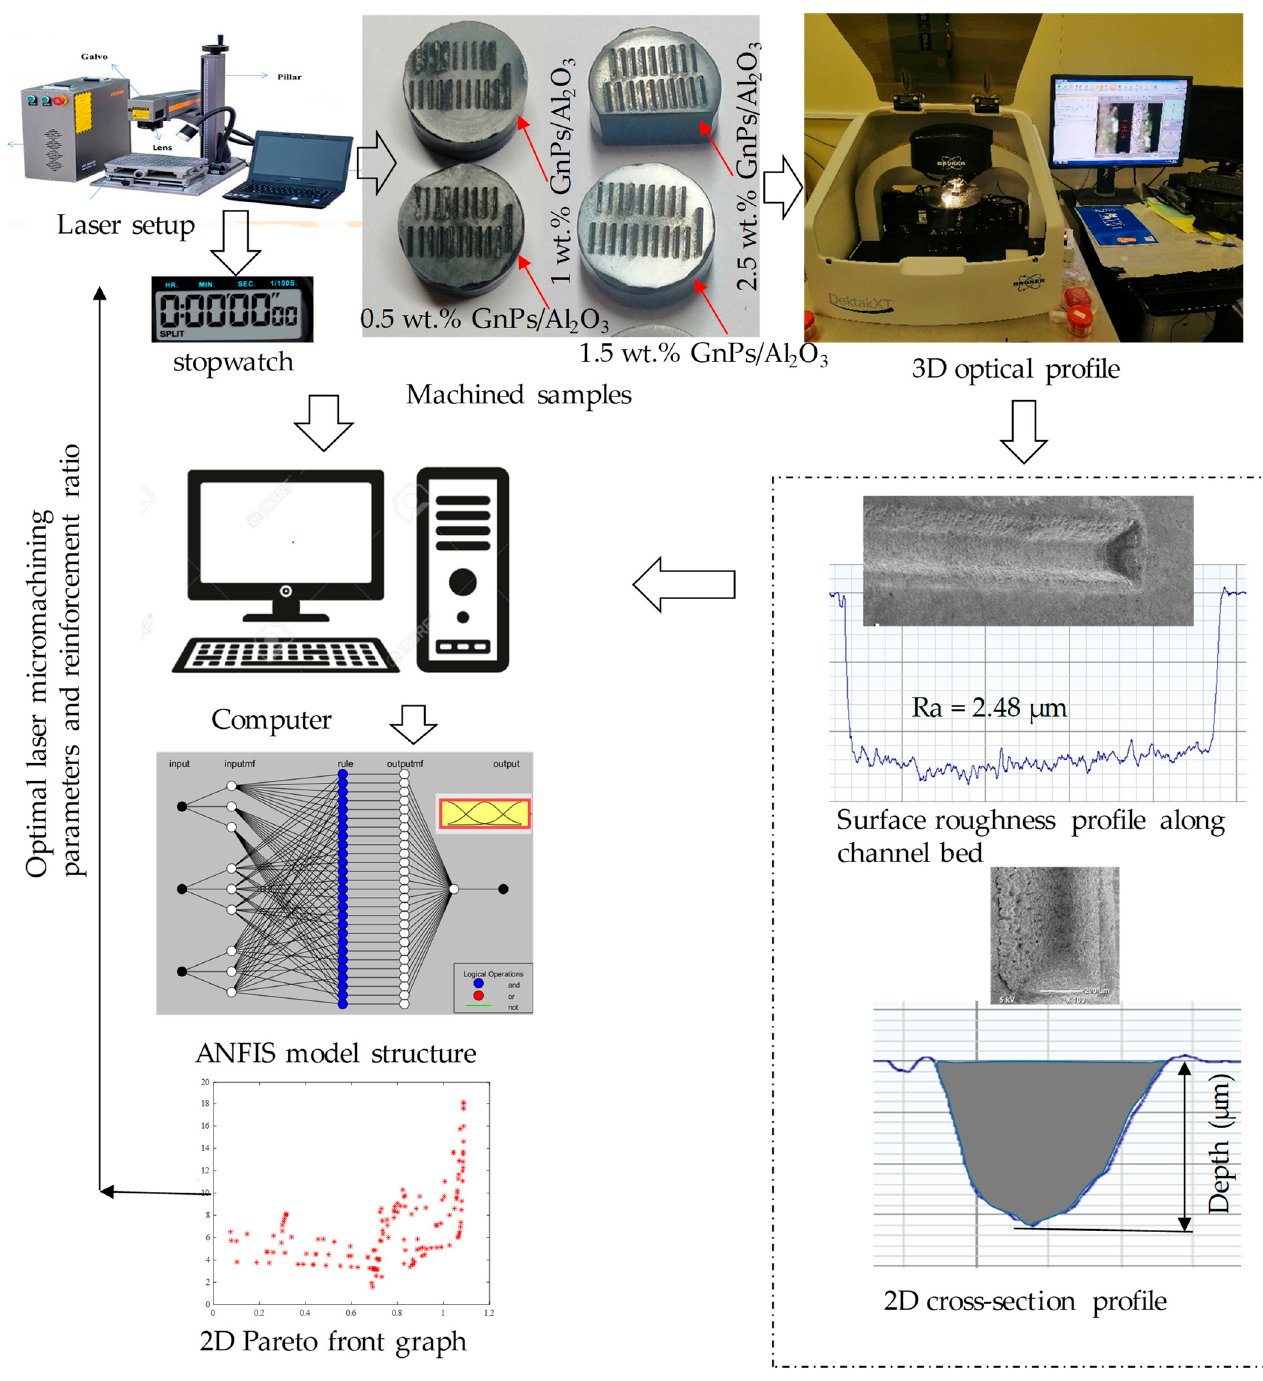
Figure 2. Schematic illustration of integrated intelligent system with experimental setup and meas- uring devices